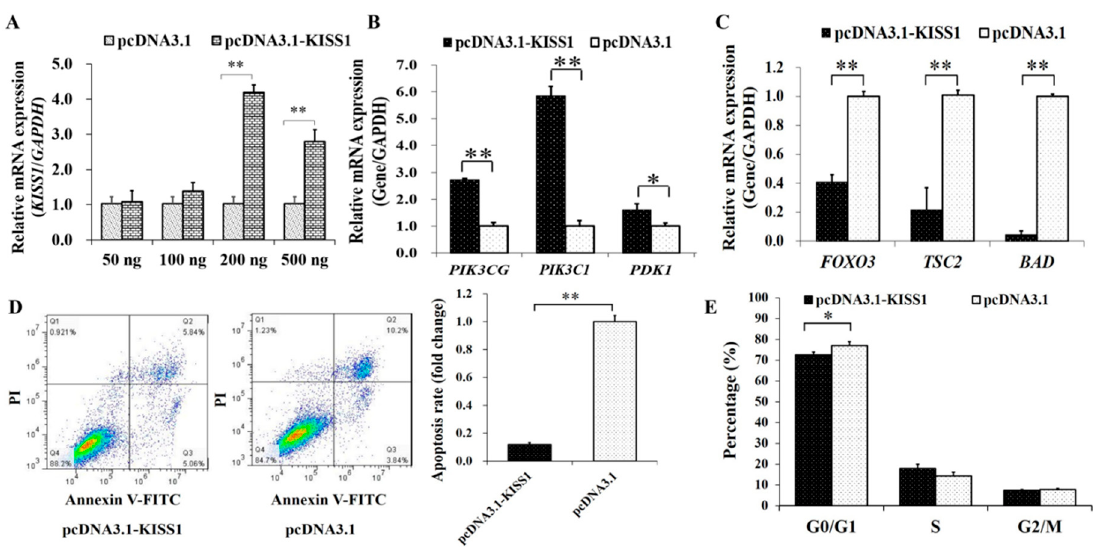
Figure 2. Biological Effects of KISS1 on cell apoptosis and cell cycle of GCs. ( A ) Relative mRNA expressions of KISS1 against the different concentrations of pcDNA3.1-KISS1 plasmid. ( B ) Relative mRNA expressions of PIK3CG , PIK3C1 , and PDK1 were stimulated by pcDNA3.1-KISS1. ( C ) Relative mRNA expressions of FOXO3 , TSC2 , and BAD were suppressed by pcDNA3.1-KISS1. ( D ) PcDNA3.1-KISS1 decreased cell apoptosis. ( E ) Effects of pcDNA3.1-KISS1 on the percentage of different cell cycle stage. * indicates p < 0.01. ** indicates p < 0.01. Data were represented as means ± SD.